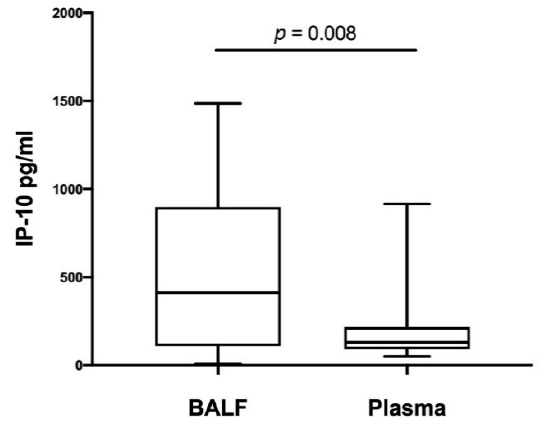
Figure 3. Comparison between IP-10 level in BALF and plasma. Definition of abbreviations: BALF— bronchoalveolar lavage fluid.